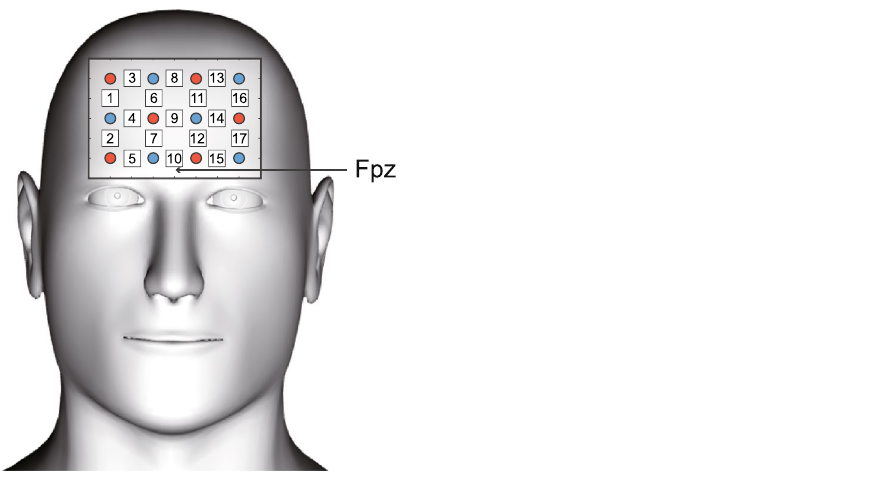
oxy-Hb concentration in the right and left PFC regions by fixing the center-bottom channel (channel 10) at Fpz according to the international 10–10 method (Fig. 1). Both oxy-Hb and deoxy-Hb concentrations were meas- ured as indicators of oxy-Hb concentration changes. Since it was previously reported that head tilts affect fNIRS measurement 57 , the participant was verbally instructed to minimize head movement during the dual task, and one of the experimenters held down a participant’s shoulders to prevent the participant’s trunk from swaying while the participant was driving the ergometer. We covered the probe set with an elastic band to prevent it from shifting on the head and prevent light from entering through gaps. Each participant was fitted with the probe set and instructed to rest for a while. The fNIRS measurement was initiated after the hemodynamics became stable. Data analysis. We analyzed the expiratory gas data in an epoch of 30 s before the end of each of the three periods M1, DT, and M2. Each participant completed the four different loads of pedaling exercise during the experiment. Since the fNIRS measurements and ergometer were manually synchronized with a hand button, there was a variance of 3–5 s in the data length. Therefore, the data available for the analyses were 170 s for M1, 115 s for DT, and 49 s for M2. We used the data in these entire intervals to analyze the fNIRS data in DT and MT. For the analysis of M1, the hemodynamics in the initial period was not stable owing to the effect of body circulations in high-intensity load; thus, we used the data after an interval of 70 s after the start of the M1 period. The expiratory gas was measured at a sampling rate of 100 Hz. We carried out breath-by-breath analysis to measure the respiratory gas exchange, thus analyzing the oxygen uptake at each breath. The mean oxygen uptake level in each task period was used as the index. We analyzed the oxygen uptake level by repeated two-way analysis of variance (with period and exercise intensity as the factors), followed by the Tukey test (Tukey–Kramer method) for multiple comparisons. The fNIRS signals were measured at a sampling rate of 12.2 Hz. The raw data were processed with a 0.01–0.3 Hz band-pass filter to remove physiologically irrelevant effects. The mean of the fNIRS signal intensi- ties during the rest interval was subtracted from that during each task interval. Then, the signal intensities during each interval were converted to Z-scores by dividing them by the standard deviation of the signal intensity during the rest interval 58–61 . The channels whose mean signal intensities exceeded the mean ± two standard deviations (SD) of all channel data were excluded from the analysis. To observe the time-series changes of hemodynamics, each task period was divided into two parts, the first half and the second half of the period. (Fig. 1). We selected the channels with significant changes in oxy-Hb concentration in the task periods compared with the rest period and used the mean values of those channels as the index of oxy-Hb in each task period. For statistical process- ing, we compared the values in DT, M1, and M2 with those in the rest period and the values in M1 and M2 with those in DT using paired t-test. The significance level was set at 0.05 (two-tailed). All statistical analyses were performed using IBM SPSS Statistics 25 (IBM SPSS Statistics Inc., Tokyo, Japan). Ethics approval and consent to participate. All participants provided written informed consent and the study was approved by the Kawasaki University of Medical Welfare (No.19-060).